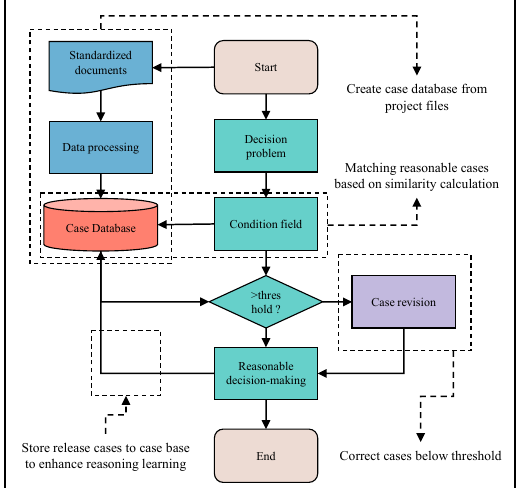
Figure 4. CBR-based decision-making process.